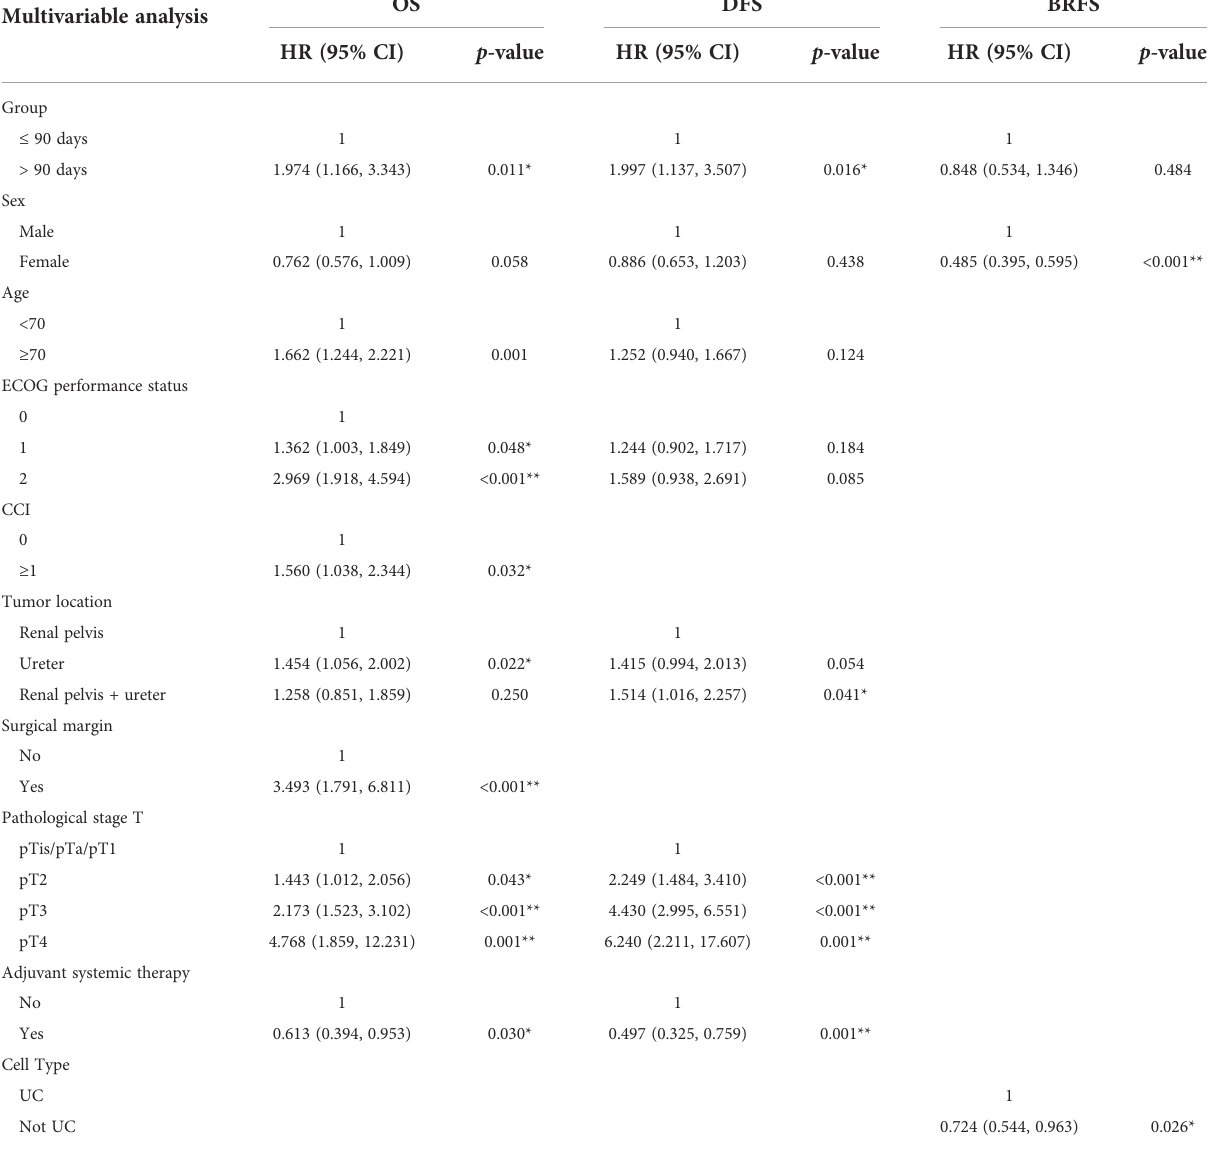
TABLE 3 Comparative multivariable survival analysis the UTUC patients. Multivariable